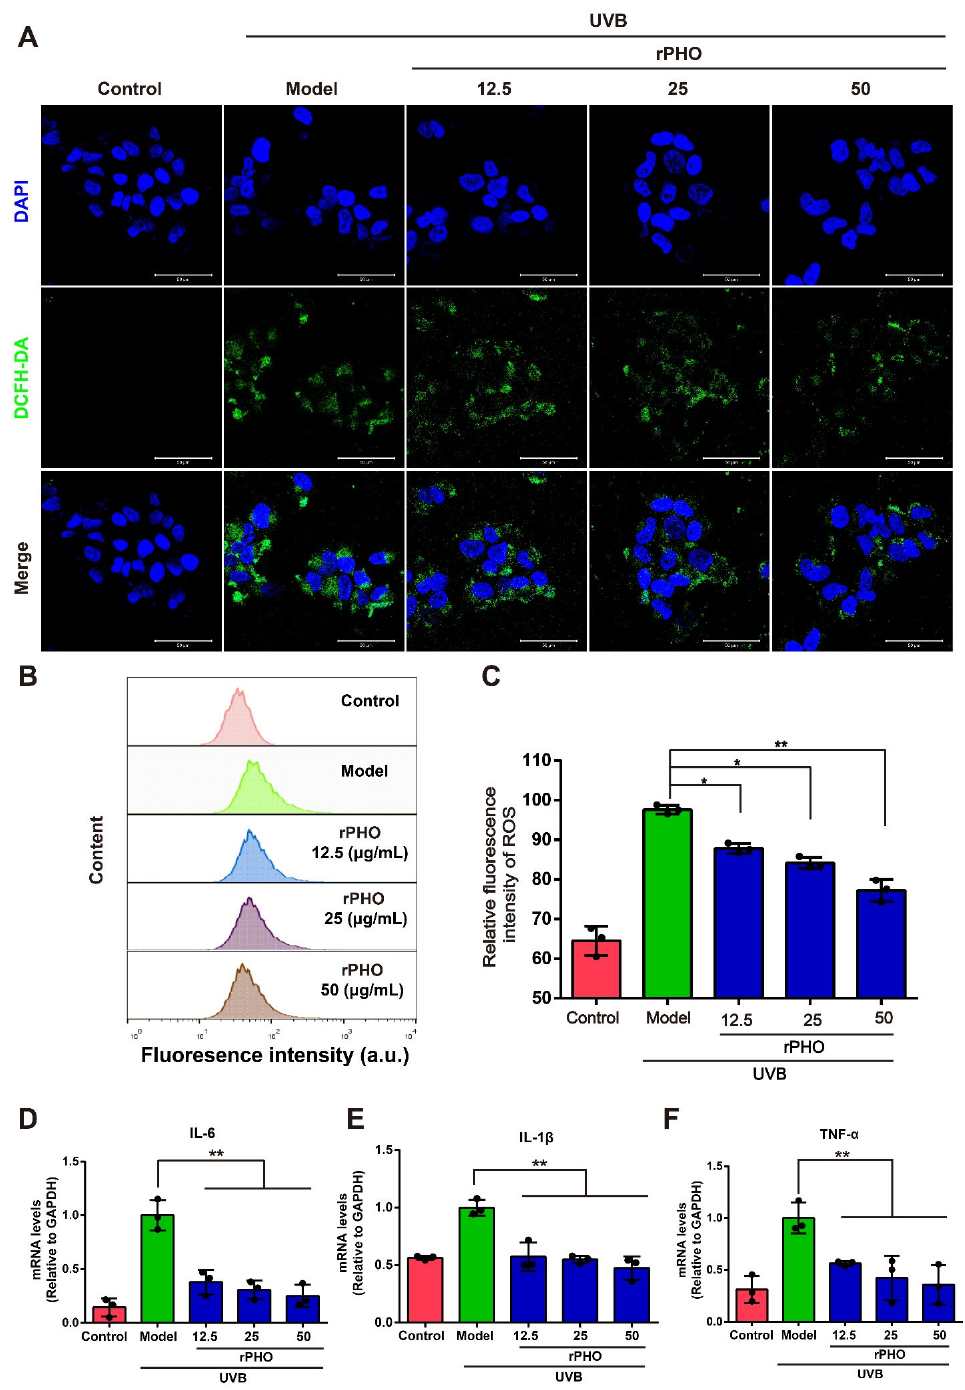
Figure 8. Photolyase inhibited UVB-induced ROS production and the release of inflammatory factors. ( A ) ROS production was analyzed by DCFH-DA staining under a fluorescence microscope. Scale bar = 50 µ m. ( B ) ROS production was measured by flow cytometry. ( C ) Quantification of intracellular ROS levels. ( D – F ) The expression levels of IL-6, IL-1 β , and TNF- α in HaCaT cells were measured. Relative levels of mRNA were normalized against levels of GAPDH. Data are expressed as means ± SD ( n = 3). * p < 0.05, ** p <